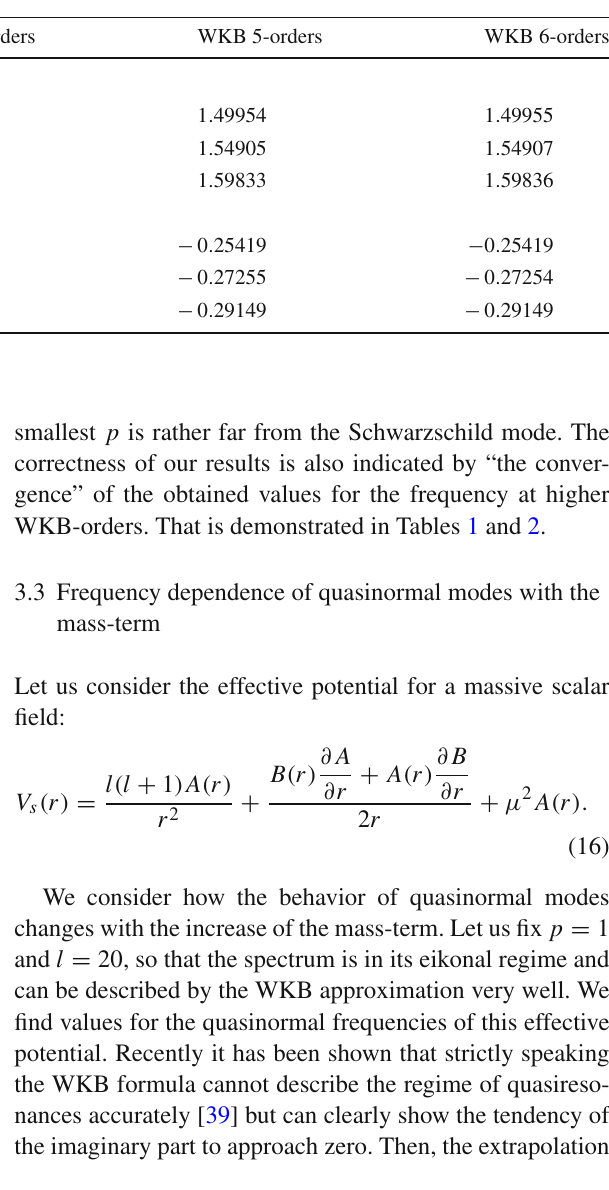
Table 2 The dependence of the real and imaginary parts of the quasinormal frequencies on the dimensionless parameter p for the electromagnetic field ( s = 1), l =